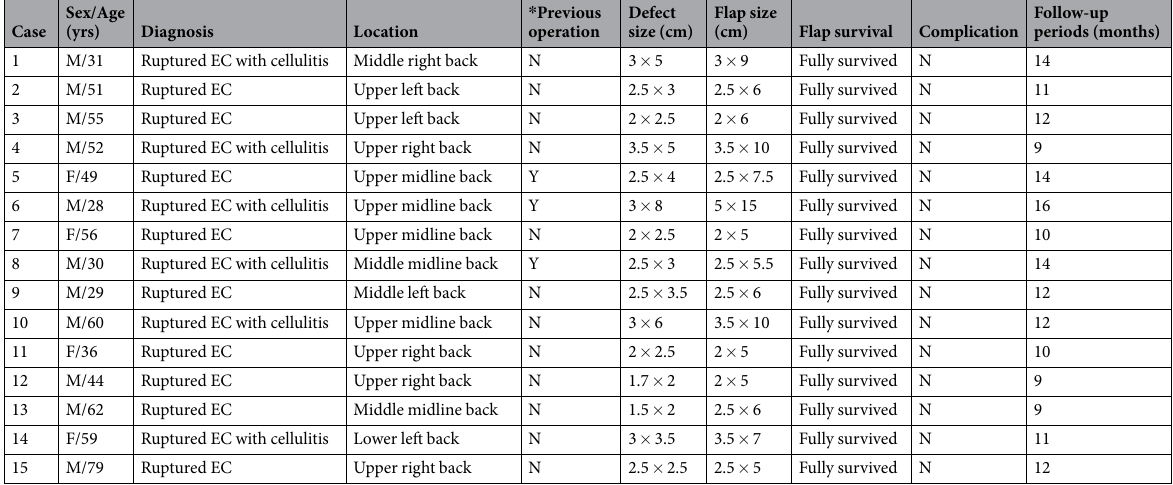
Table 1. Patient characteristics and perioperative data. * Previous operation means previous surgical management (excision of EC and primary closure) for ECs before keystone perforator island flap reconstruction. EC, epidermoid